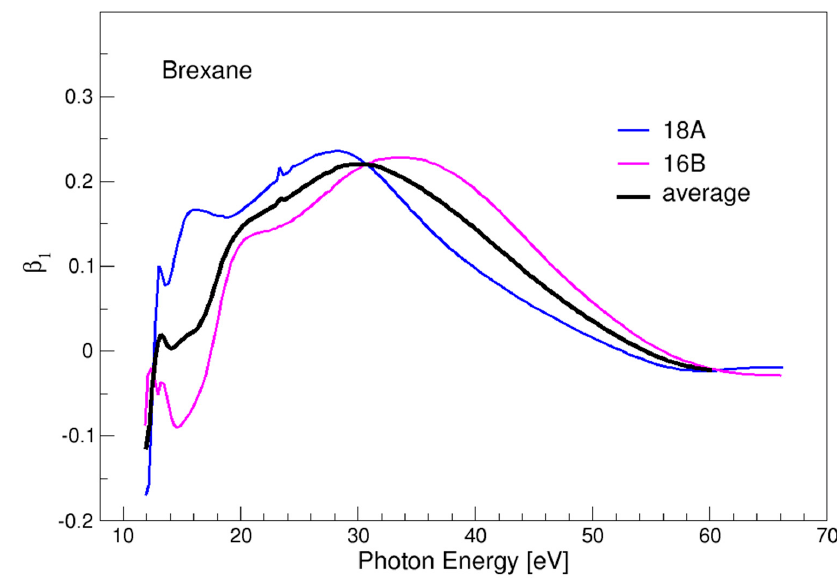
Figure 5. β 1 parameter for the two outermost ionizations, 16B and 18A, and the average value, in brexane.